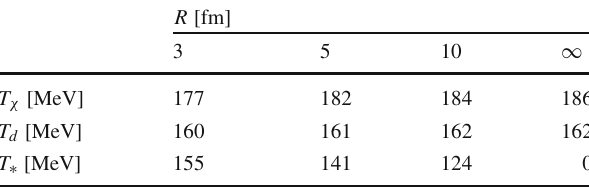
Table 1 Using the polynomial Polyakov loop potential and taking dif- ferent values for the drop’s radius R , we show the chiral critical temper- ature T χ of the u and d condensates, the critical deconfinement temper- ature T d of the Polyakov loop expectation value, and the temperature T ∗ below which the drop’s pressure becomes negative. T χ and T d are